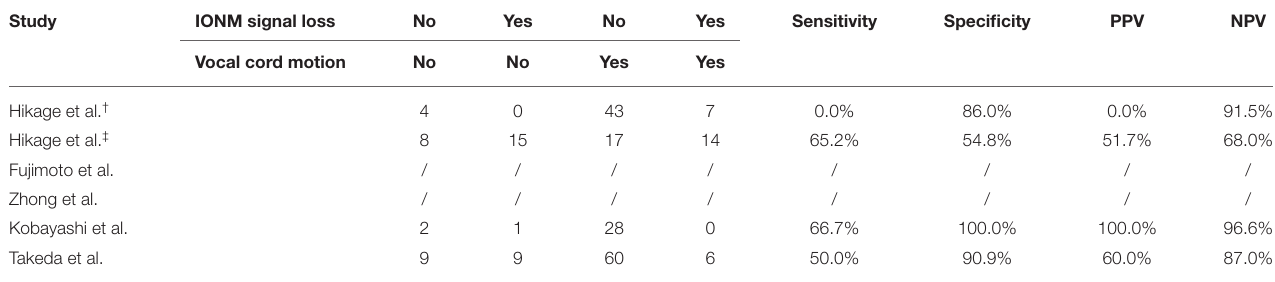
TABLE 2 | Results of IONM.